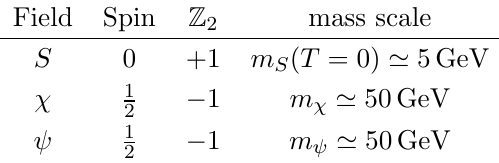
Table 1 . The new particles we introduce in section 2 with their respective charges and mass scales. All new particles are SM gauge